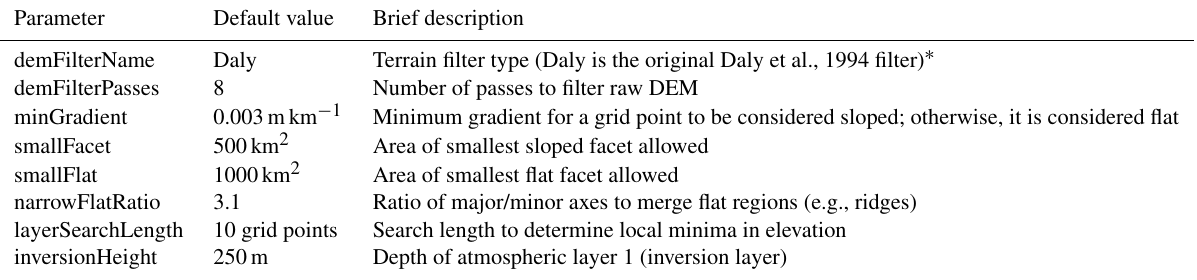
Table 1. Terrain pre-processing model parameters.